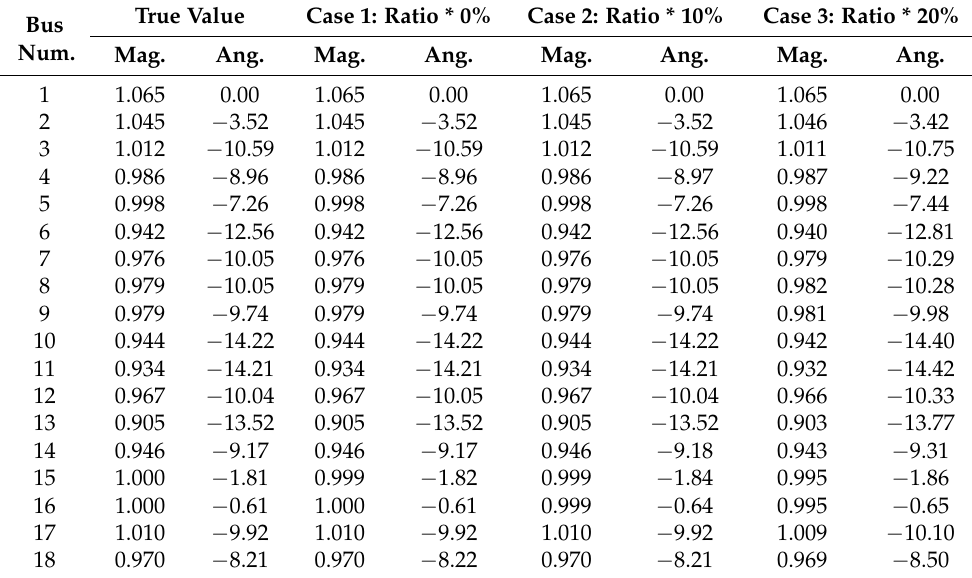
Table 5. Estimated voltage magnitude and angle for Scenario A.